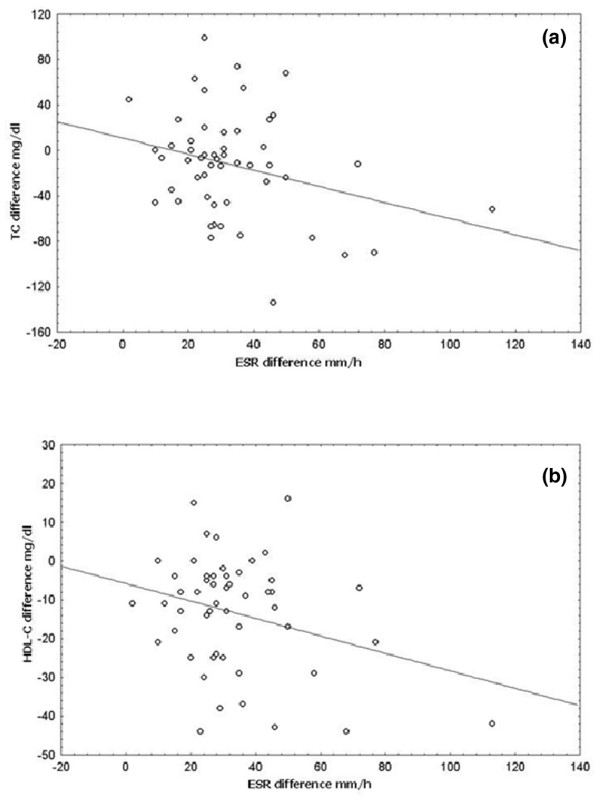
Correlation of total cholesterol (TC) and high-density lipoprotein cholesterol (HDL-C) with erythrocyte sedimentation rate (ESR). Inverse correlation of ESR differences with (a) TC and (b) HDL-C differences (r = -0.28, p < 0.04 and r = -0.30, p < 0.03, respectively).